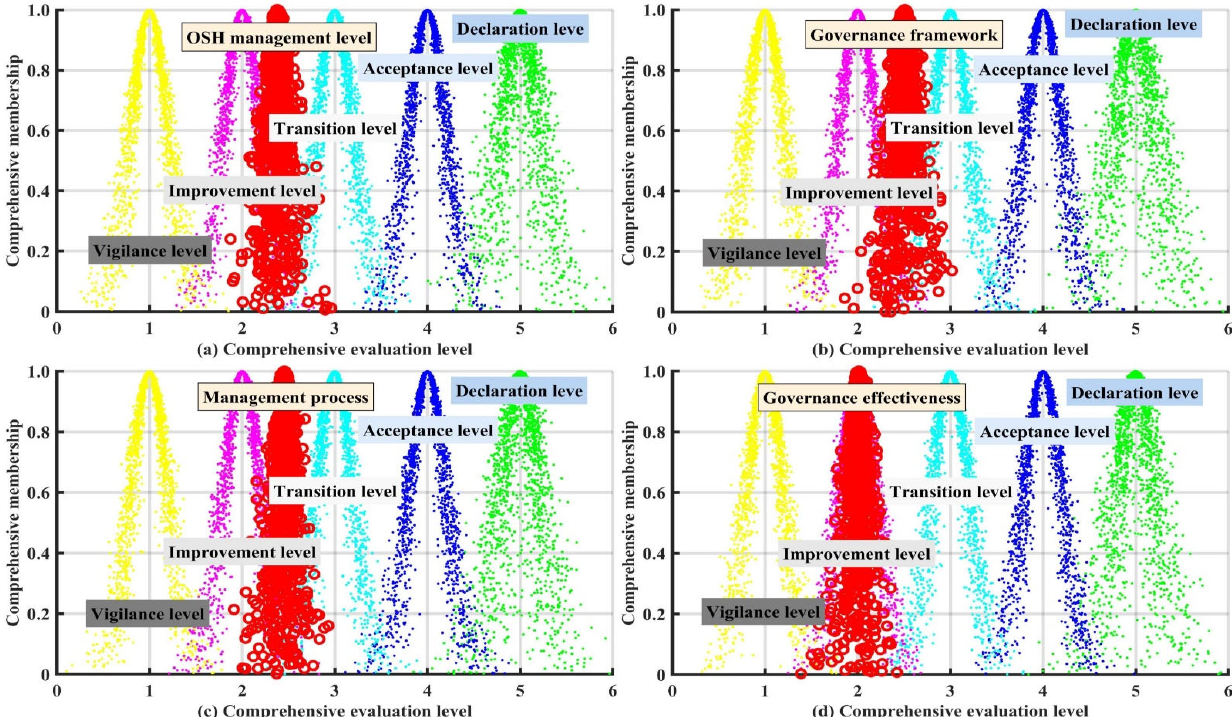
Figure 4. Comprehensive evaluation results of the overall and FPE three ‐ dimensional subsystem.